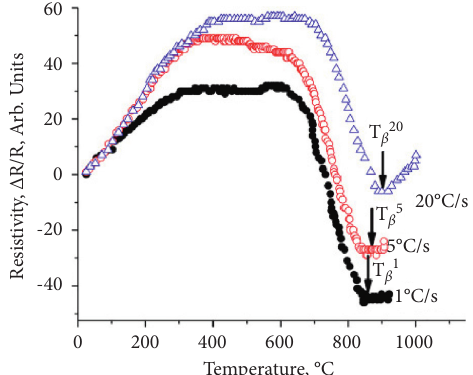
Figure 5: Relationship between the RHT temperature and resis- tivity at different heating